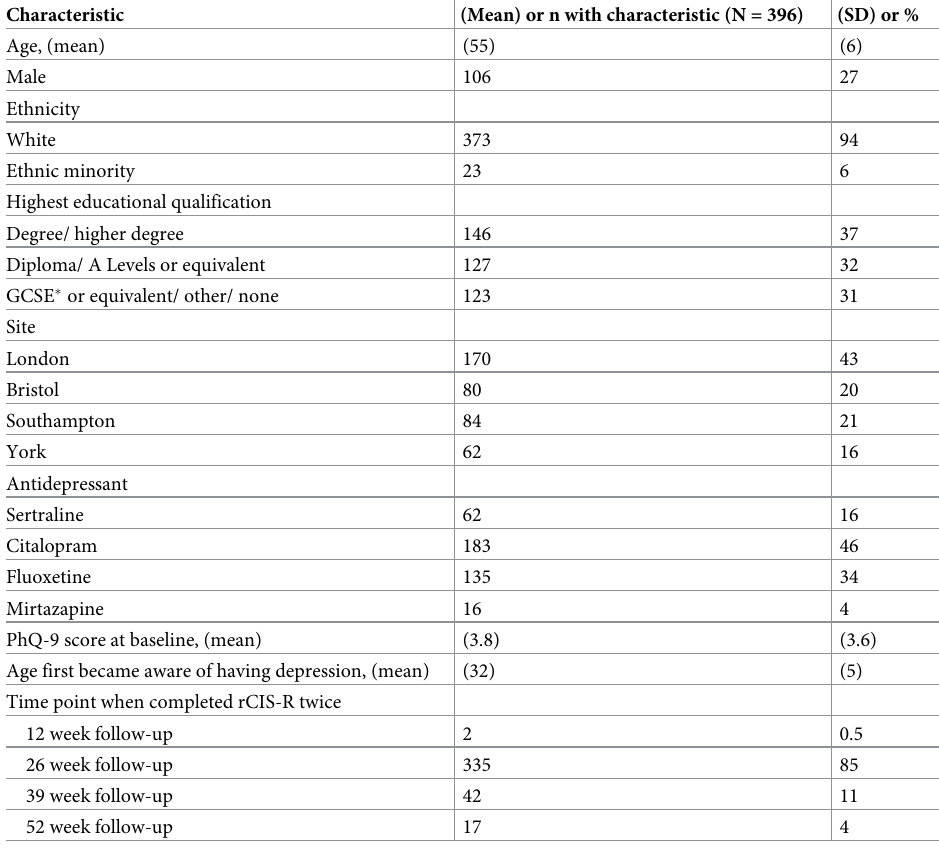
Table 1. Baseline characteristics of the sample who completed rCIS-R twice at the same follow-up appointment. Characteristic